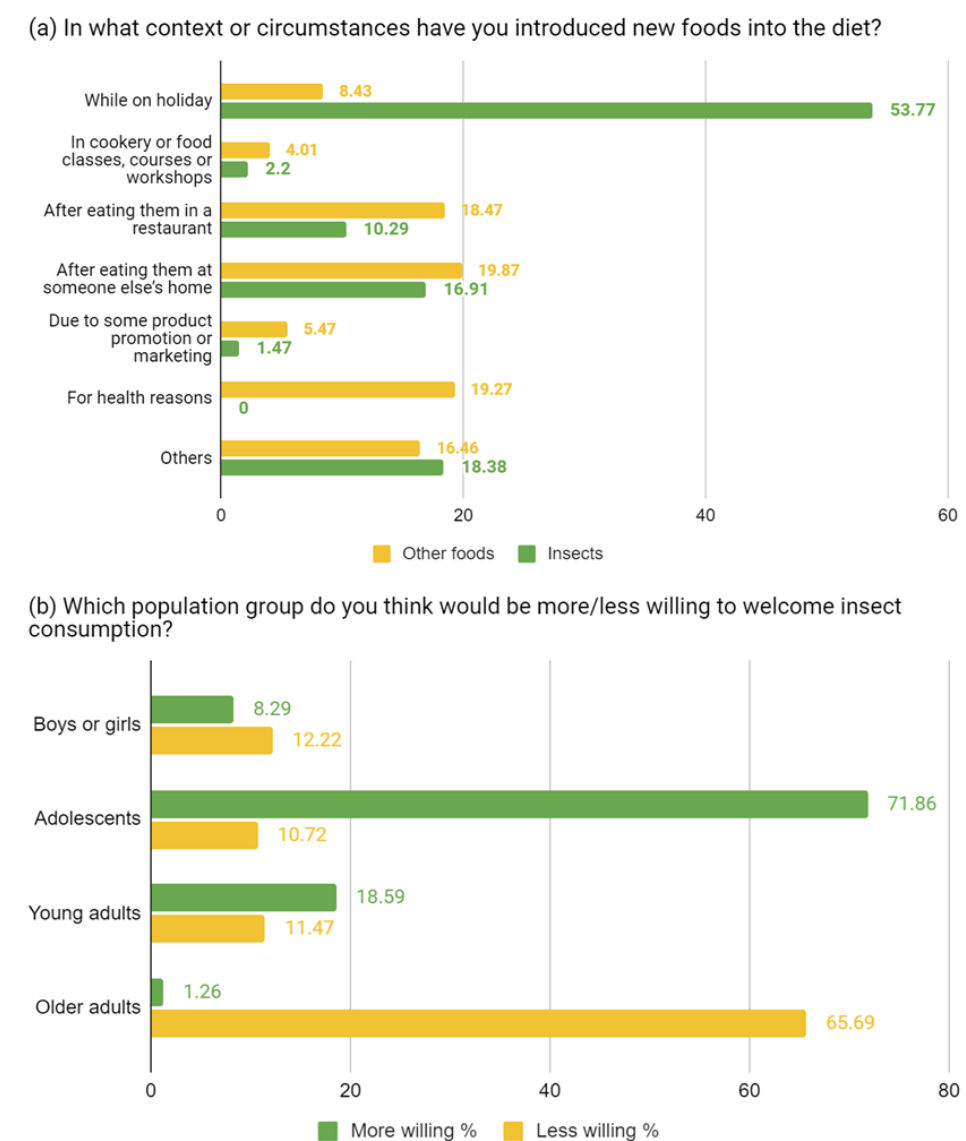
Figure 1. Distribution of food introduction contexts and level of reception by population group. ( a ) Context or circumstances of introduction of new foods into the diet. ( b ) Population group and willingness to welcome insect consumption.